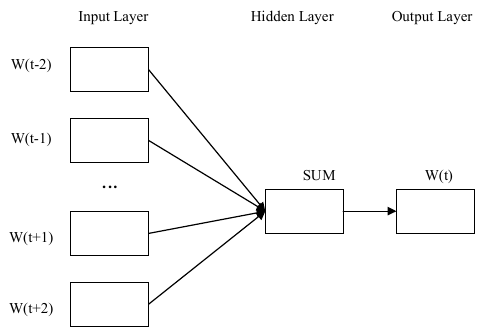
Figure 6. Training the word vectors using the Continuous Bag-of-Words Model (CBOW) mode, predict the current word from the input of the context sentence.